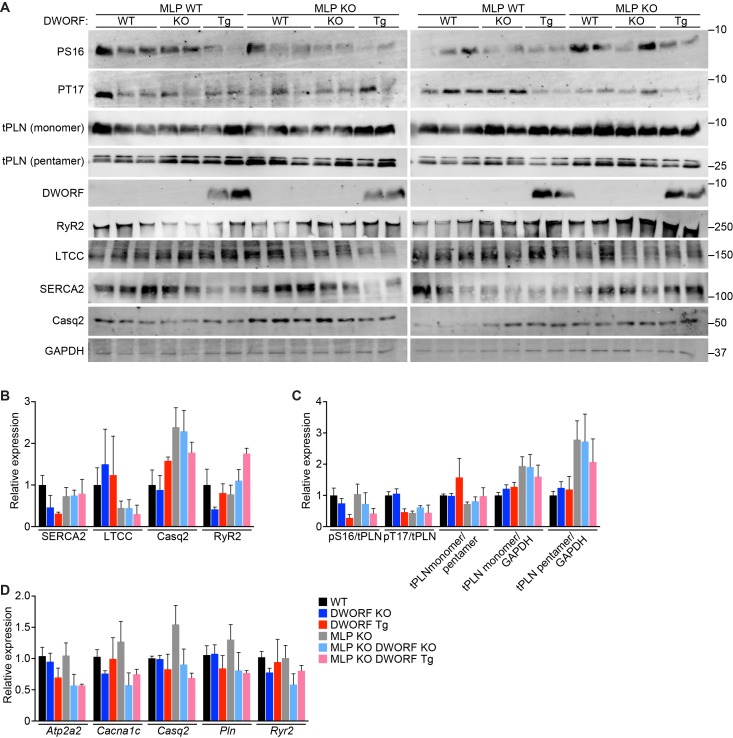
Expression and post-translational modifications of Ca2+-handling proteins.(A) Immunoblots of cardiac homogenates from mice with the indicated genotypes. (B) Immunoblots were quantified using ImageJ and normalized to GAPDH. LTCC, L-type Ca2+ channel (α1C-subunit); Casq2, calsequestrin 2; RyR2, ryanodine receptor 2; GAPDH, glyceraldehyde 3-phosphate dehydrogenase. (C) Quantification of the phosphorylation status and oligomerization of phospholamban as assessed by western blot (panel A) and expressed as relative to WT. Western blots were quantified with ImageJ software. Phosphorylation blots (PS16 and PT17) were normalized to total PLN (tPLN). Total PLN was normalized to GAPDH. tPLN, total phospholamban; PS16, phospho-serine 16 on PLN; PT17, phospho-threonine 17 on PLN. Data are expressed as mean ±SD for n = 4–6 mice per genotype. (D) RNA levels of the indicated genes as quantified by qRT-PCR in 8-week-old heart tissue. Atp2a2, SERCA2a; Cacna1c, α1C-subunit of the L-type Ca2+ channel; Casq2, calsequestrin 2; Pln, phosholamban; Ryr2, ryanodine receptor 2. Data are normalized to 18S values and presented as expression level relative to WT, mean ±SD for n = 4–5 mice per genotype.